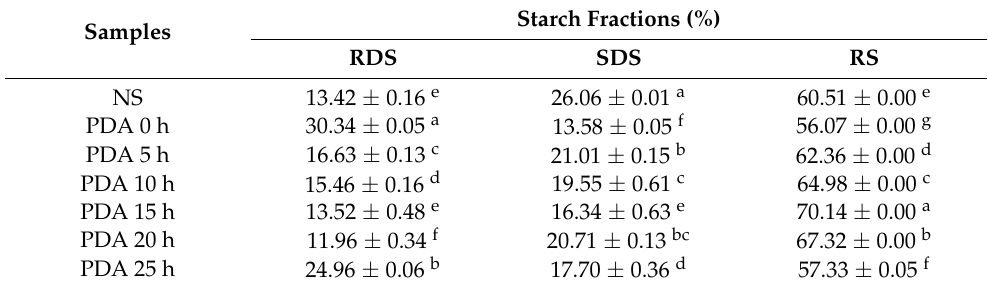
Table 6. In vitro digestion properties of native and debranching combined with autoclaving starches.